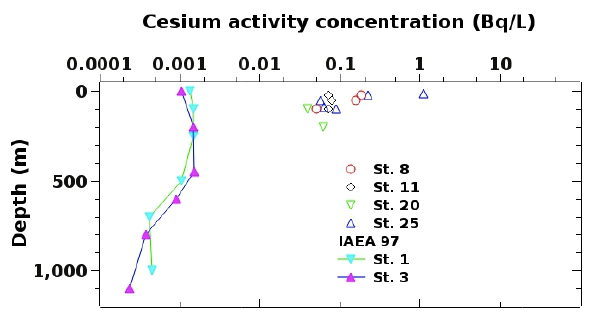
Fig. 2. A comparison of 137 Cs profiles as obtained from the IAEA’97 expedition (global fallout impact; Povinec et al., 2003a) with the results presented in this paper, which are based on anal- ysis of seawater samples collected during the KOK expedition (Fukushima impact) in the NW Pacific Ocean. IAEA’97 data were decay-corrected to June 2011.